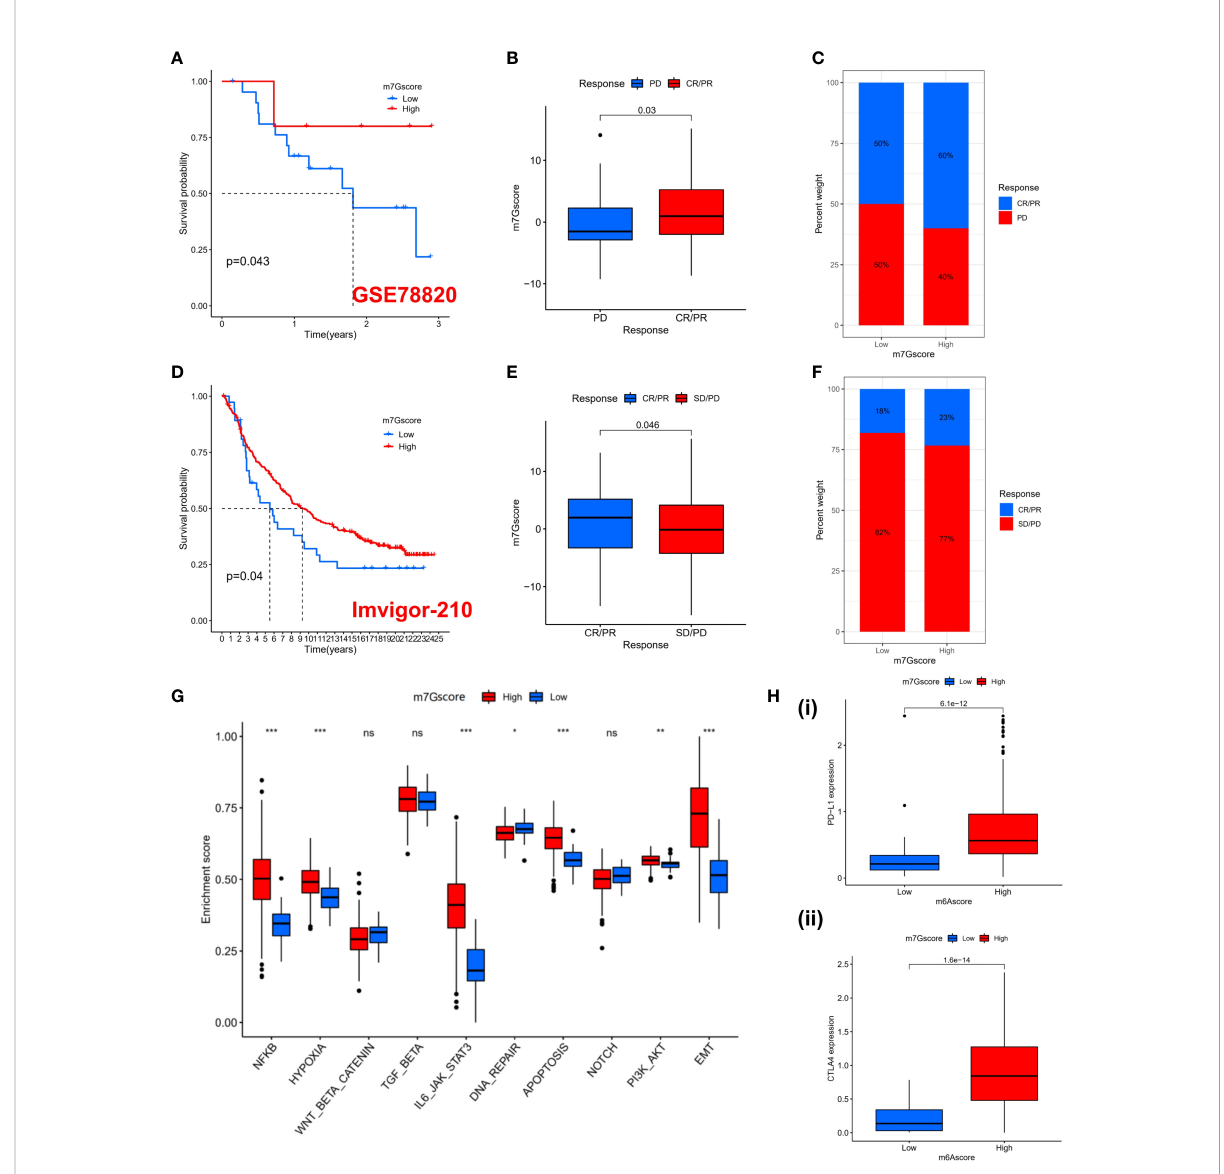
FIGURE 6 The prediction to Immunotherapy using m7G score. (A) K-M survival analysis of OS in high and low m7G score groups in the GSE78220 cohort (p = 0.043). (B) Distribution of m7G scores between immune response and non-response in the GSE78220 cohort. (p=0.03). (C) The percentage of patients with different responses to immune therapy in the GSE78220 cohort. (D) K-M survival analysis of OS in high and low m7G score groups in the IMvigor210 cohort (p = 0.04). (E) Distribution of m7G scores between immune response and non-response in the IMvigor210 cohort. (p=0.046). (F) The percentage of patients with different responses to immune therapy in the IMvigor210 cohort. (G) GSVA enrichment analysis based on Hallmark gene set according to high and low m7G scores in the PD-L1 cohort. (*p < 0.05 **p < 0.01 ***p < 0.001). (H) PD-L1 (i) and CTLA4 (ii) expression levels between high and low m7G score subgroups. NS, no signi fi cance; CR, complete response; PR, partial response; SD, stable disease; PD, progressive